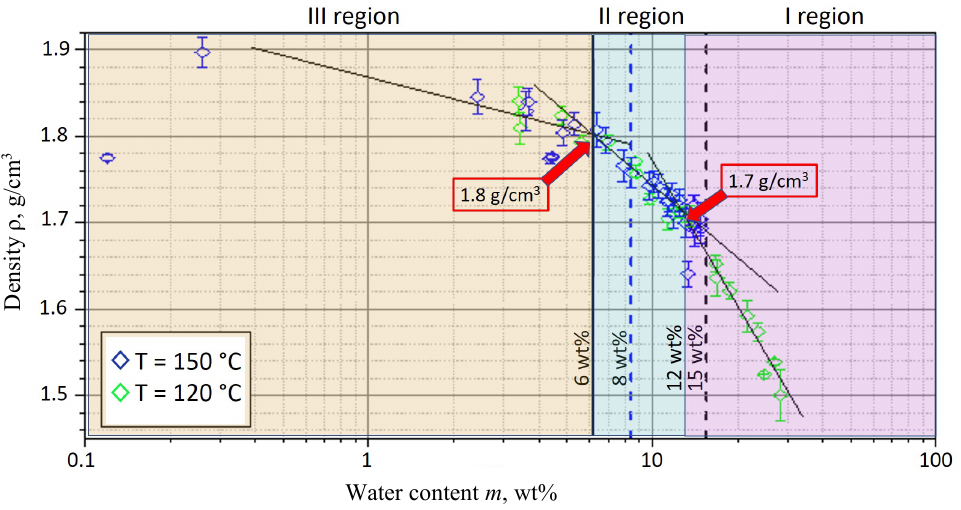
Fig. 2. Correlation between density ρ and water content m of the phosphoric acid solutions at 120 °C (green) and 150 °C (blue). Vertical lines mark particular compositions discussed in the text. Three regions are highlighted. It is worth to note that the density of neat H 3 PO 4 at 25 °C is 1.87 g∙cm −3 , so that in